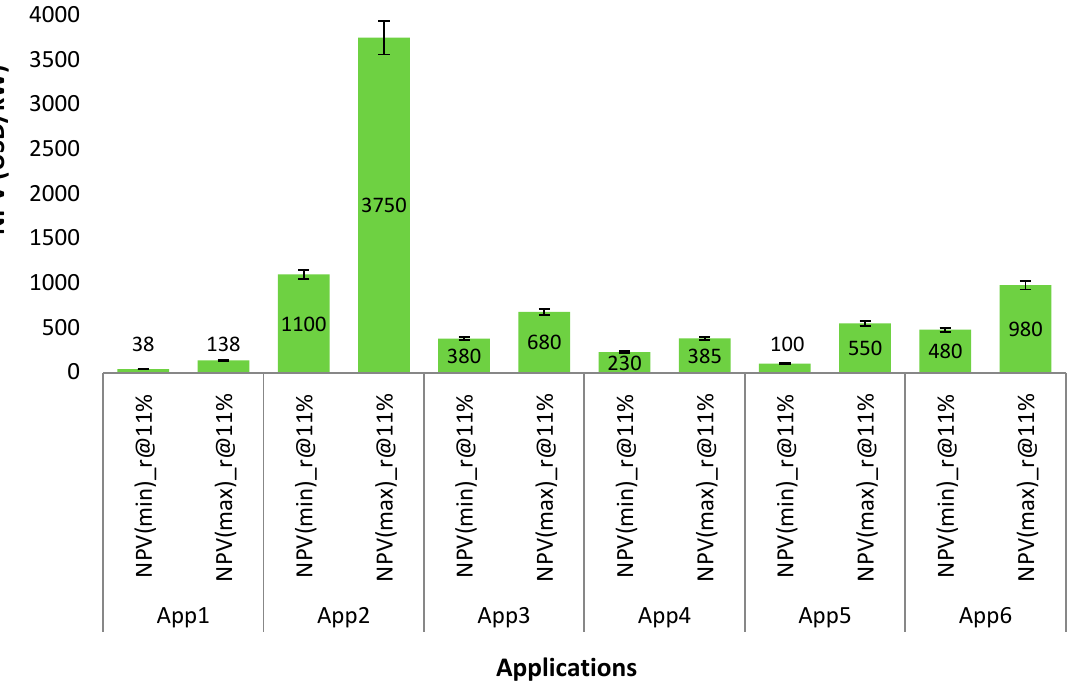
Figure 16. Net Present Value (USD/kW) at a range of electricity purchasing prices (USD 30–50/MWh) and a discount rate of 11%.